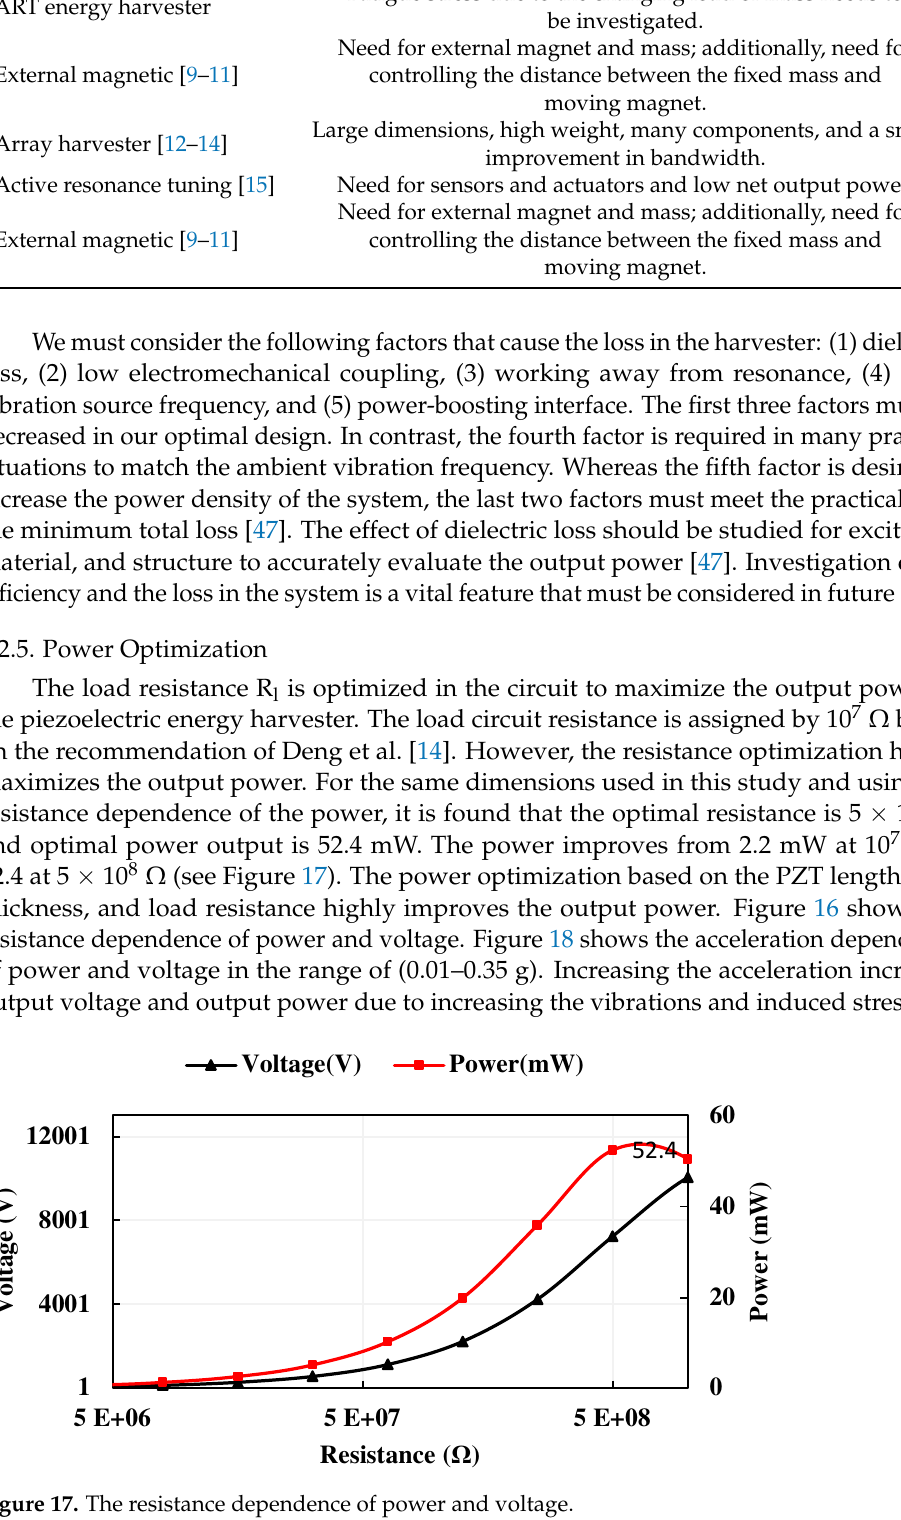
Figure 17. The resistance dependence of power and voltage.